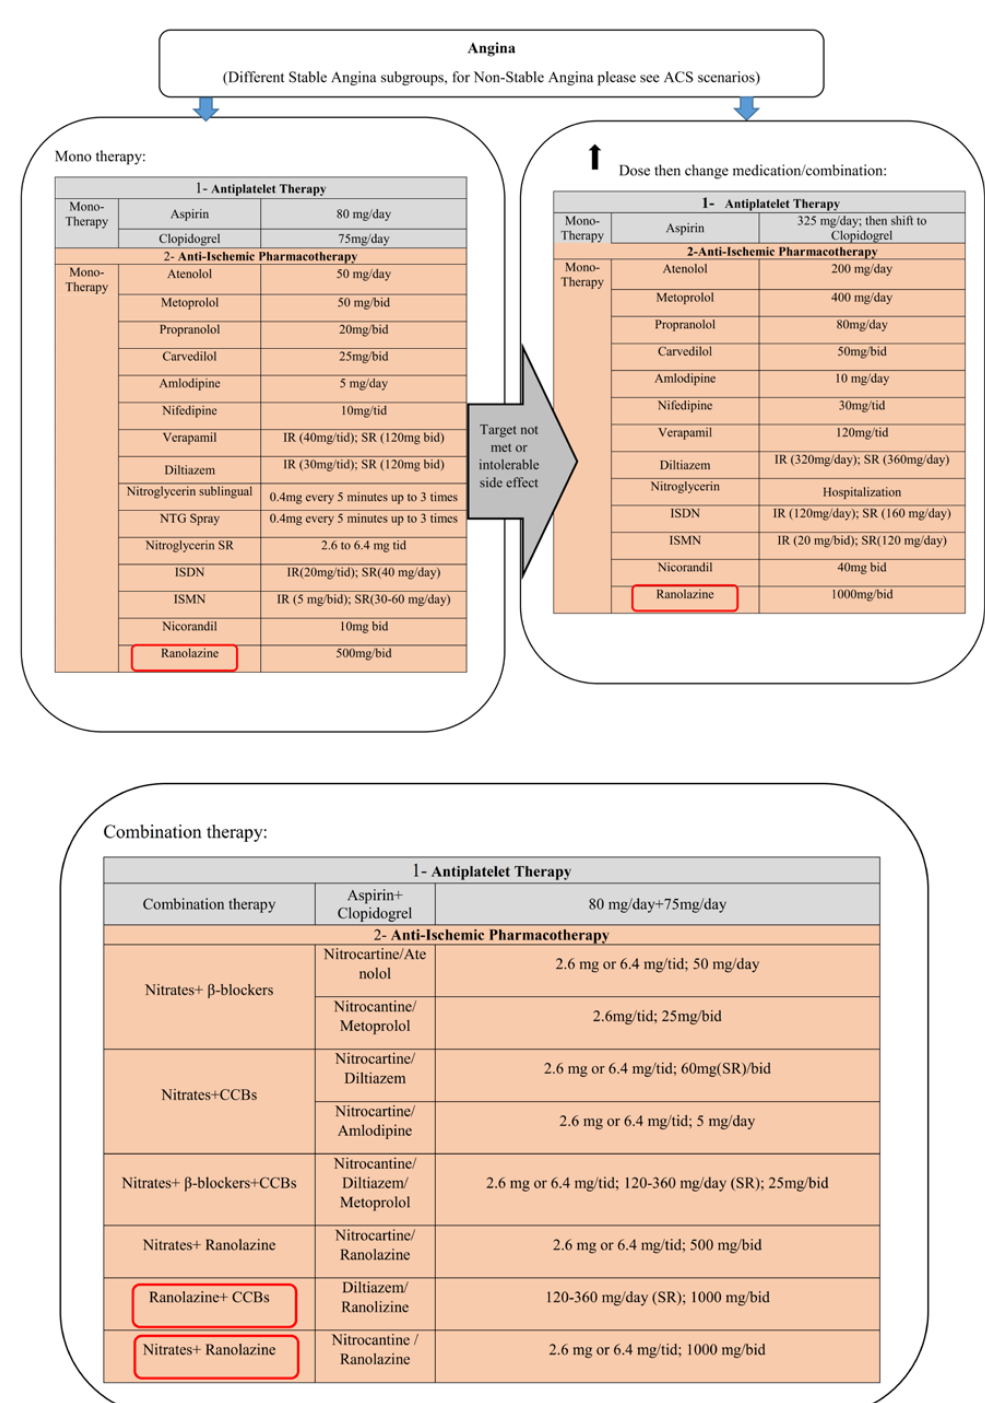
Figure 2A. The different medication therapy scenarios in acute coronary syndrome (ACS).